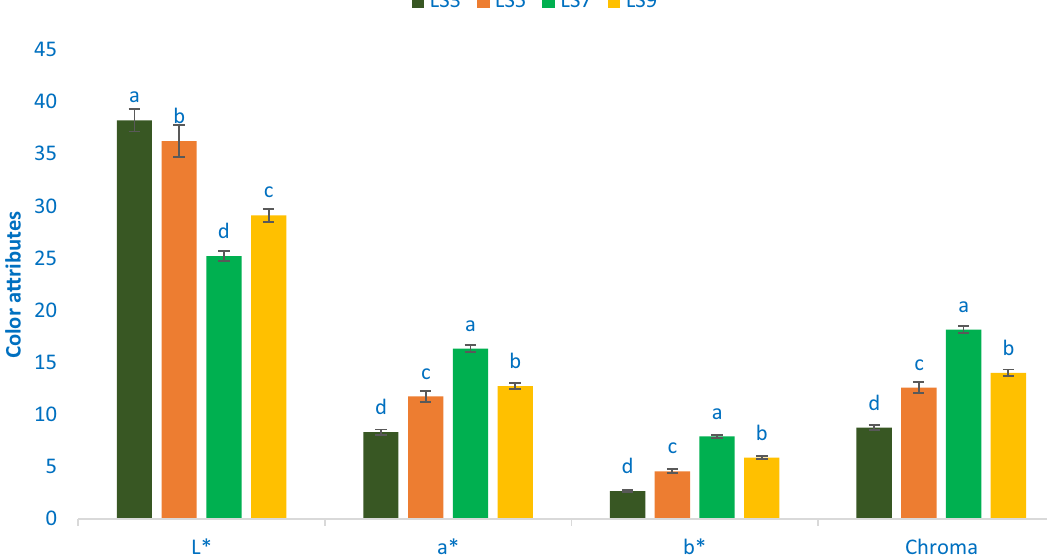
Figure 1. Color attributes in four selected A. gangeticus leafy vegetables, L*, Lightness; a*, Redness/greenness; b*, Yellowness/blueness, different letters in the bar are differed significantly by Duncan Multiple Range Test ((P < 0.01), (n =